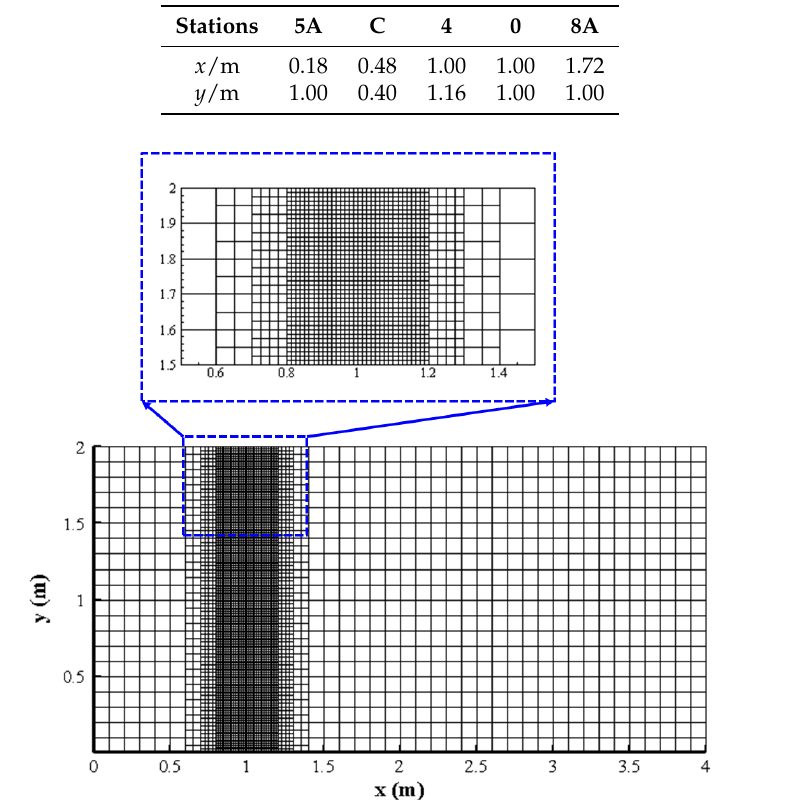
Figure 4. The computational grids for partial dam break